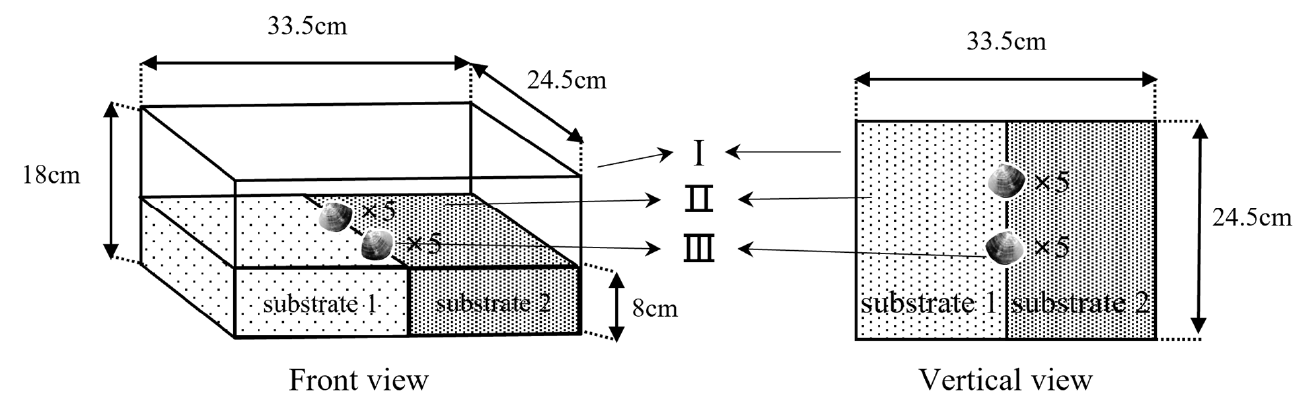
Figure 2. The device for substrate pairwise combinations. Unit Ι is the polypropylene plastic box. The different types of substrates ( Ⅱ ) are separated by a partition ( Ⅲ ).